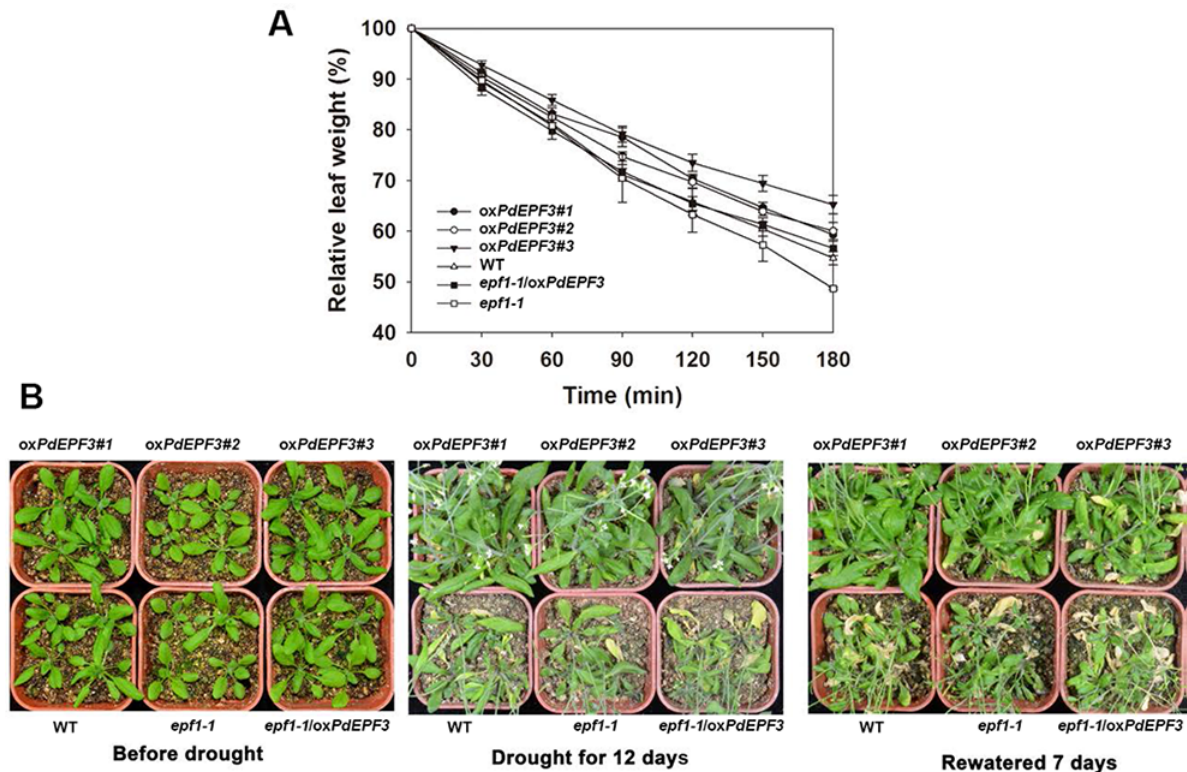
Fig. 5 Overexpression of PdEPF3 confers drought tolerance in Arabidopsis . ( A ) Water loss from detached leaves; water loss from a 0.5-g sample of detached leaves per plant was measured at the indicated time points. Three measurements were averaged for each time point. Data are means ± SE . ( B ) Morphological differences in drought experiments. The seedlings were grown in soil for 3 weeks under well-watered conditions; thereafter, water was withheld for 12 days, and then the plants were rewatered for 1